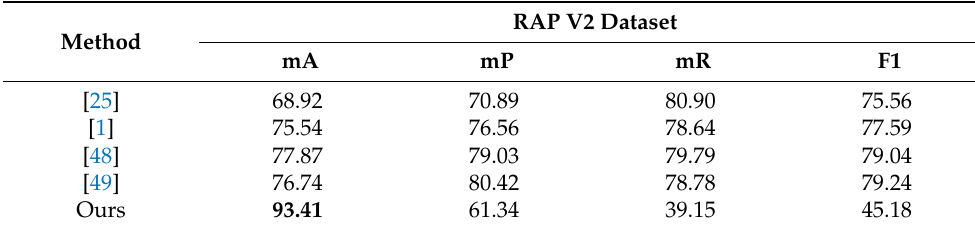
Figure 18. Feature map of each block of Model 5. Table 7. Comparison with the state-of-the-art methods on the RAP v2 dataset.